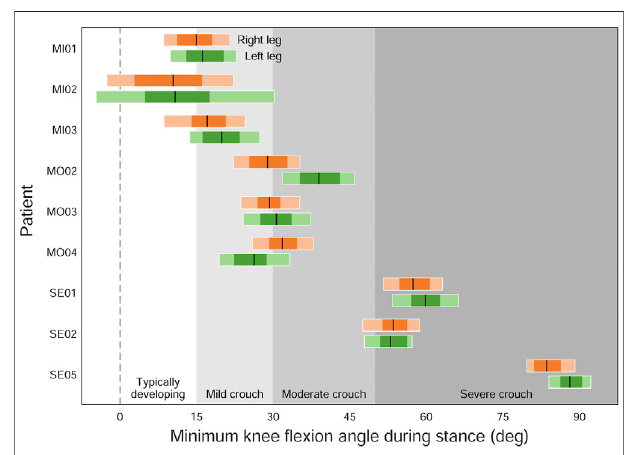
FIGURE 6 | The effect of marker registration uncertainty on the classi fi cation of patients with cerebral palsy walking in a crouch gait (Steele et al., 2013). Individual legs were classi fi ed based on their minimum knee fl exion angle (peak knee extension angle) during stance: typically developing (below 15 ° ), mild crouch (15 – 30 ° ), moderate crouch (30 – 50 ° ), and severe crouch (above 50 ° ). Blacklines are theoriginalclassi fi cations; dark and light horizontal bars indicate the ranges of minimum knee fl exion angles resulting from 1 and 2 cm of uncertainty, respectively.